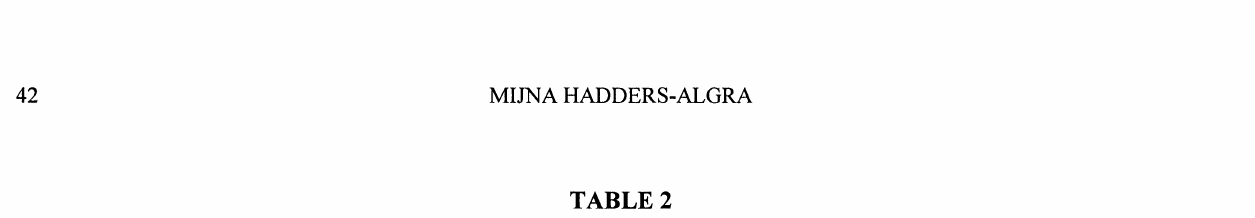
Functional, i.e., neurobehavioral clusters of MND, based on the neurological examination of Touwen